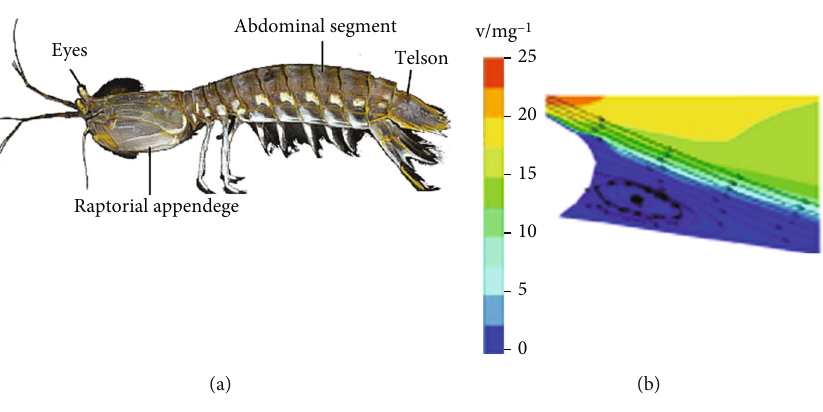
Figure 14: Structure of mantis shrimp [66].